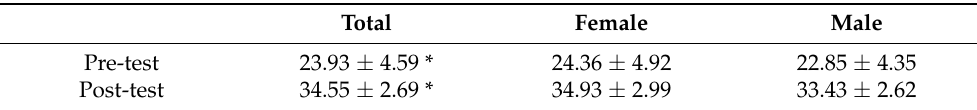
Table 3. Average and standard deviations from the overall results of the eHealth Literacy (eHEALS) questionnaire.